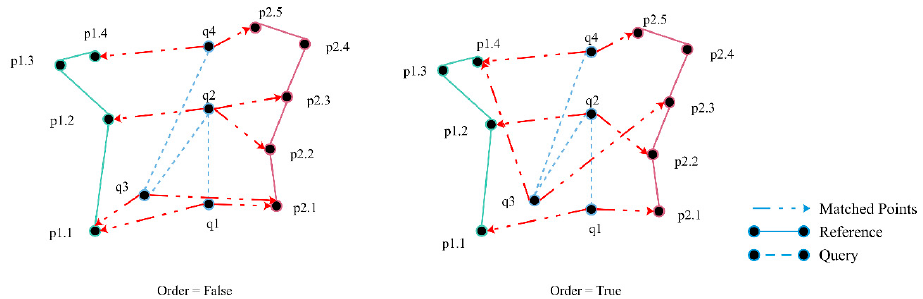
Figure 2. Enforcing the order constraint for shortest distance computation.